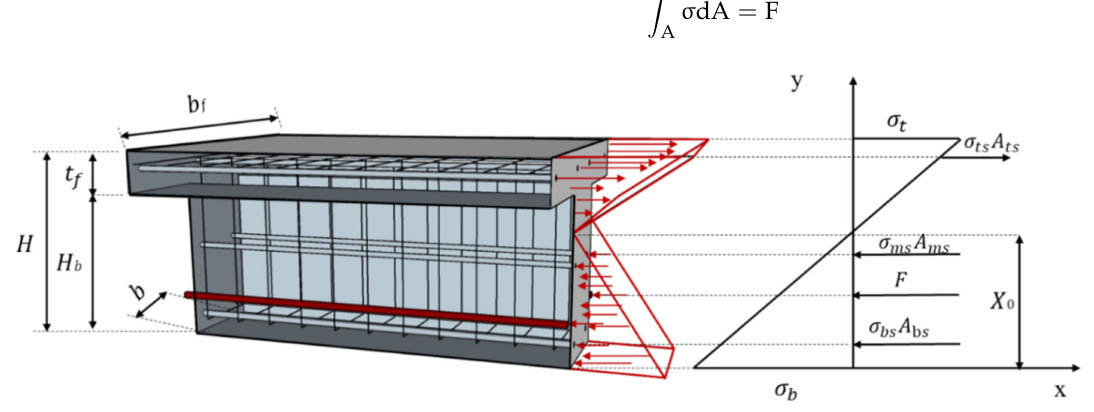
Figure 2. Schematic for the force equilibrium of the